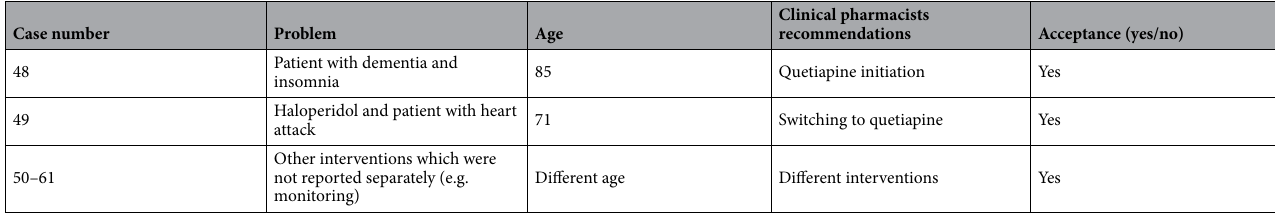
Table 3. Proposed and accepted recommendations in antipsychotic therapy. ADHD attention deficit hyperactivity disorder, SR sustained release